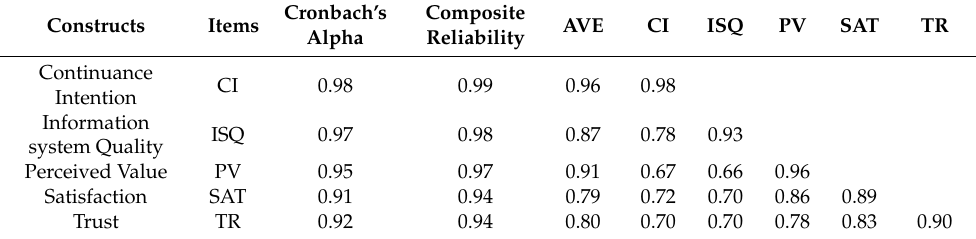
Table 3. Construct reliability and discriminant